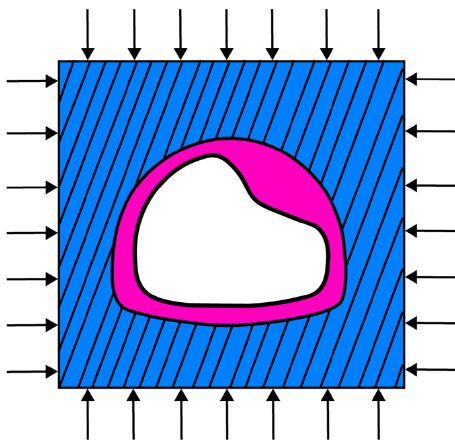
Figure 5. Schematic diagram of the surrounding rock mass